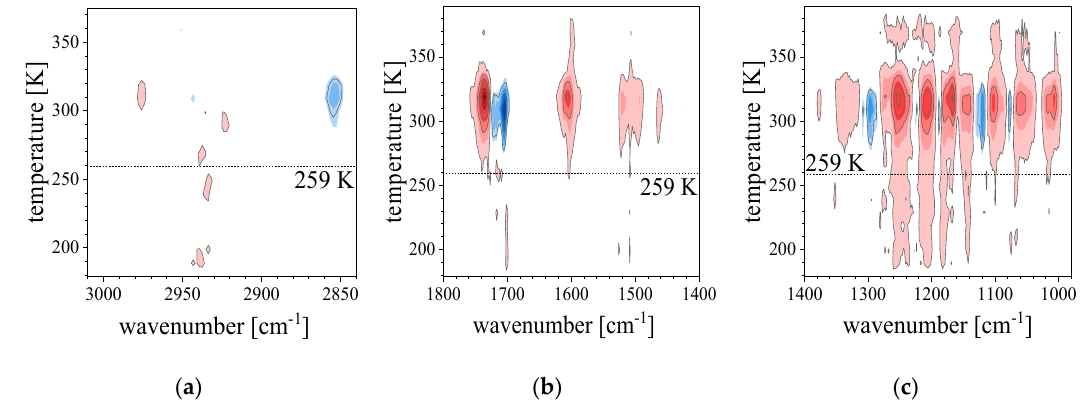
Figure 5. Perturbation-correlation moving window two-dimensional analysis (PCMW2D) correlation synchronous maps in the cooling mode of 3F7HPhH7 in the wavenumber regions of: ( a ) 3100–2800 cm − 1 , ( b ) 1800–1400 cm − 1 and ( c ) 1400–1000 cm − 1 . The red or blue areas represent positive or negative correlation intensities, respectively.